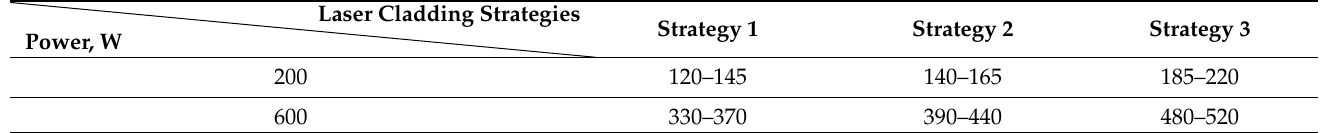
Figure 9. Optical photographs of the longitudinal section of thin walls. Table 3. Layer height for different laser cladding